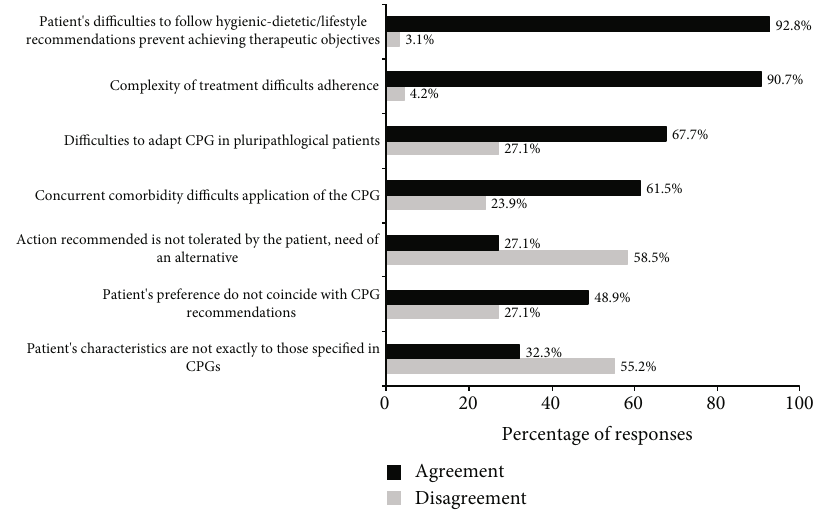
Figure 2: Factors related to the patient preventing adherence to recommendations of CPGs (5-point Likert scale; agree: moderately/strongly agree (scores 4-5), disagree: moderately/strongly disagree (scores